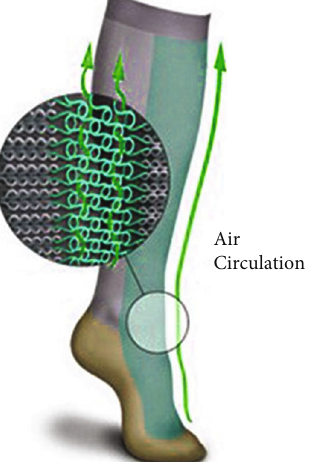
Figure 9: Pique is an open structure allowing for freedom of air through the